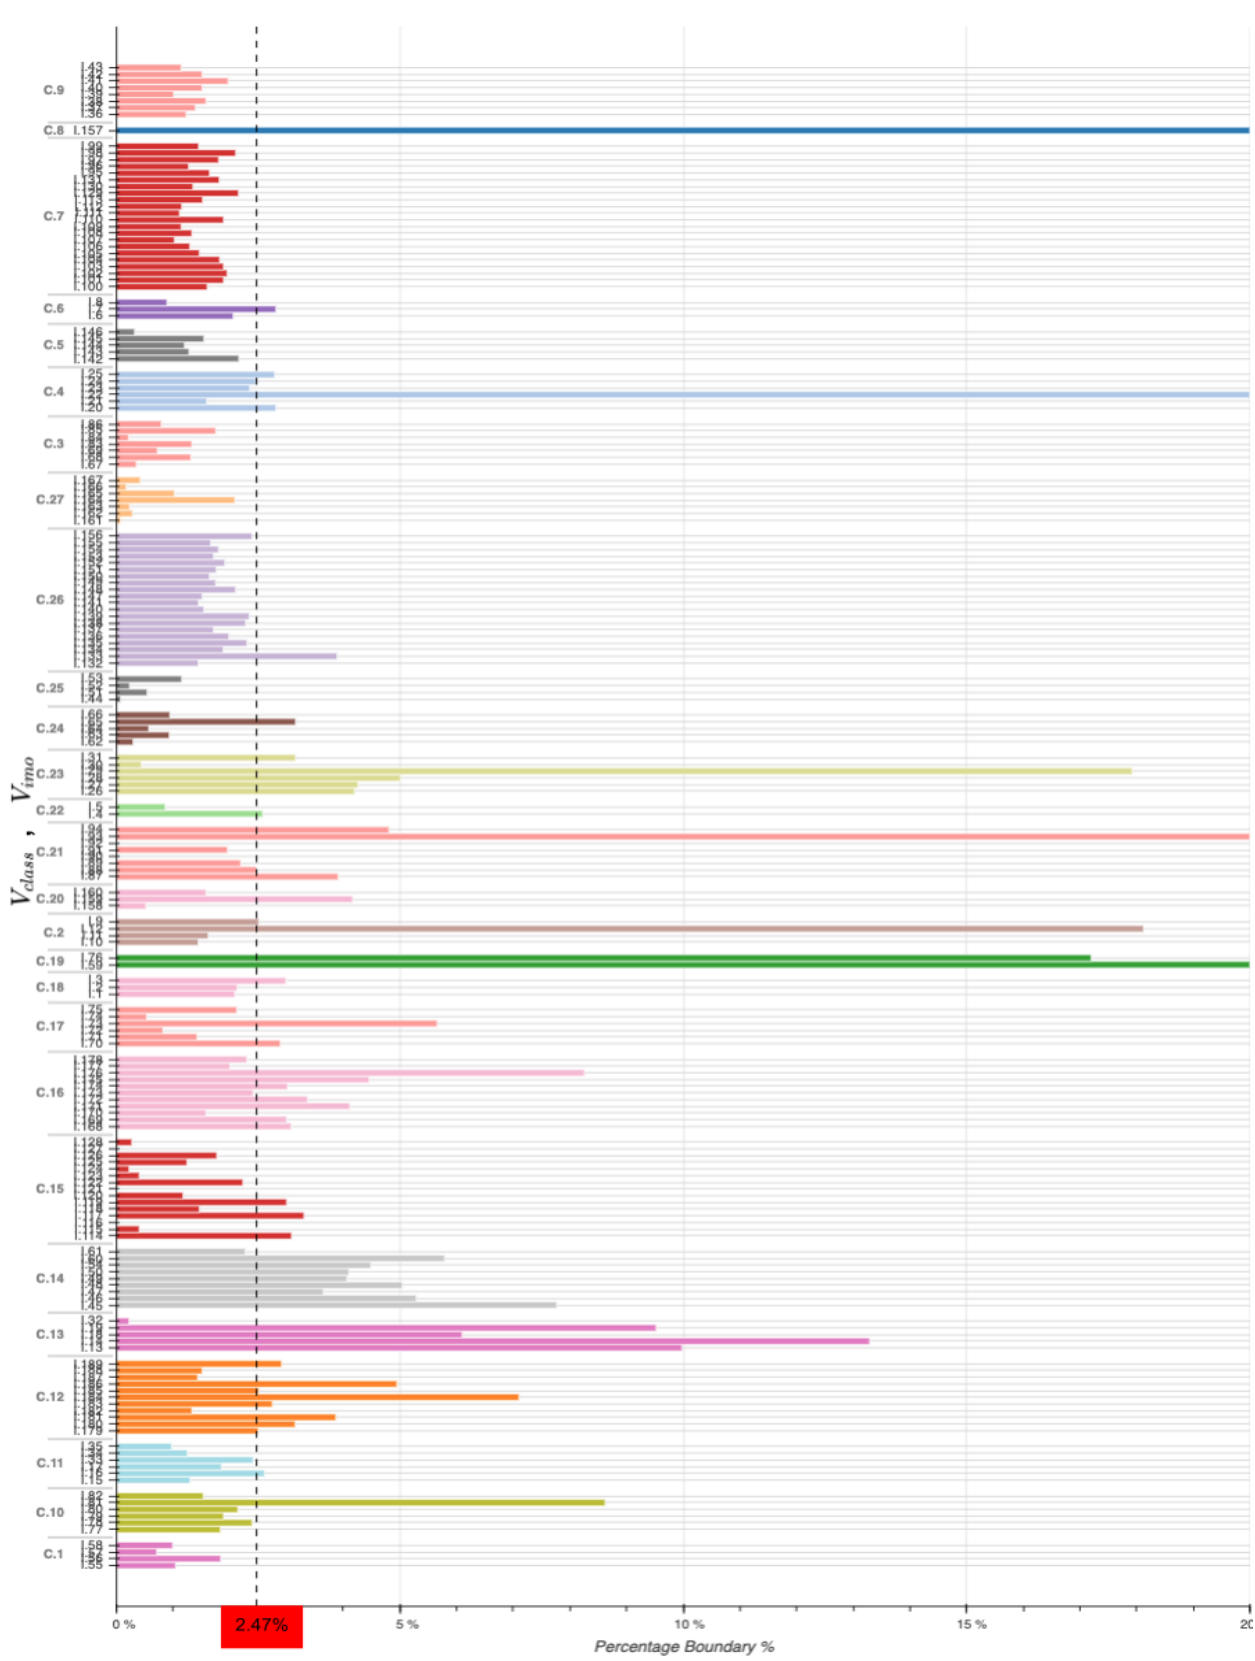
Figure 10. Barplot of U dev boundary percentage by vessel class V class and IMO number V imo